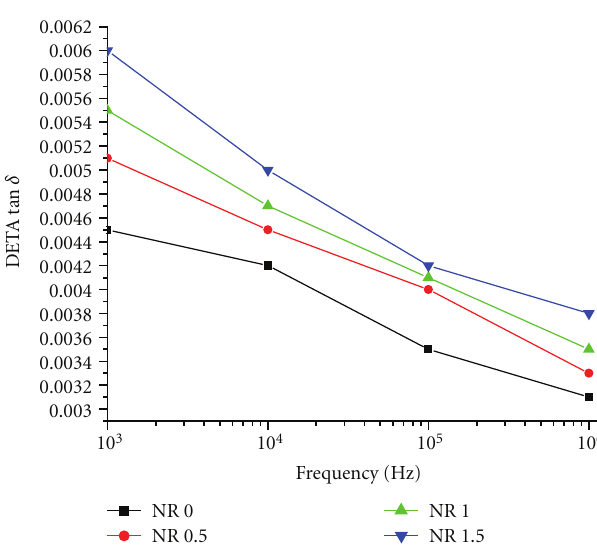
Figure 9: Frequency dependence of DETA tan δ at a di ff erent degree of fullerene filling at 90 ◦